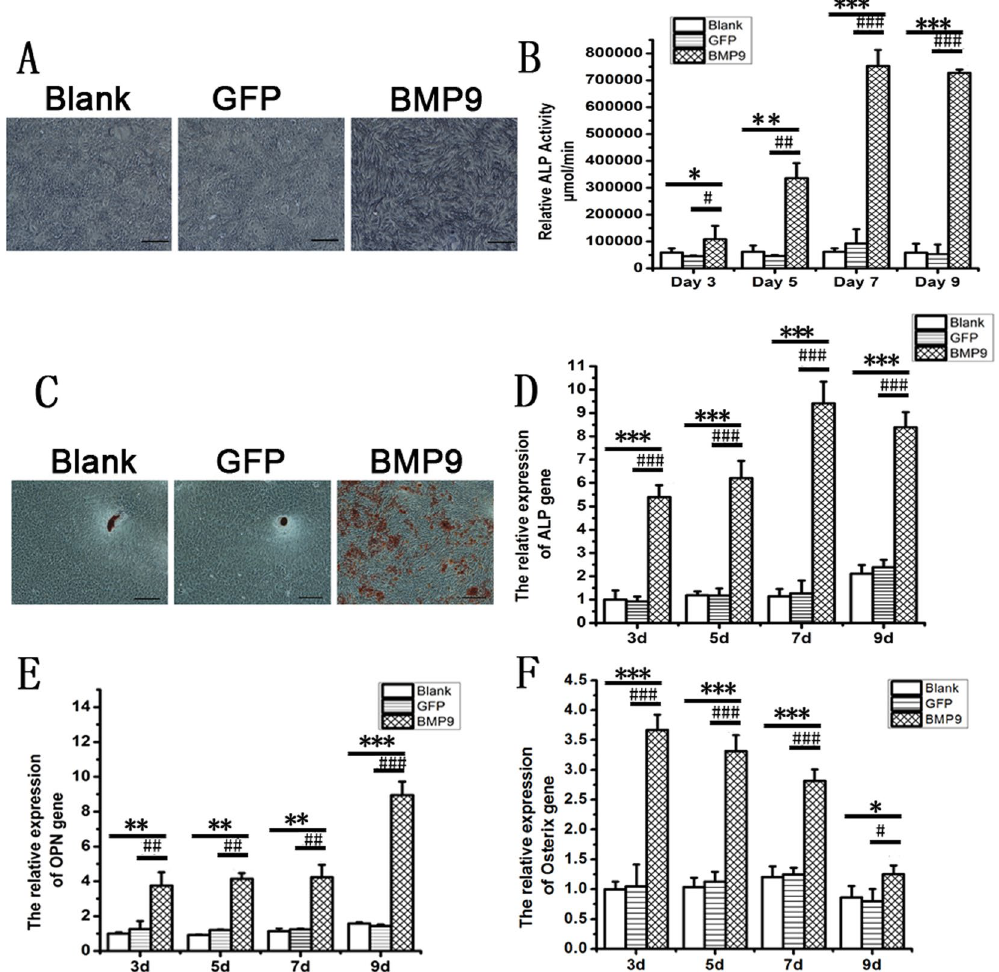
Figure 2. BMP9-induced osteogenic differentiation of rDFCs. ( A ) ALP staining intensity was enhanced in BMP9 group when compared with the blank group and GFP group. Bars: 50 μ m. ( B ) ALP activity was also significantly increased on days 3, 5, 7, 9 in BMP9 group when compared with the blank group and GFP group. ( C ) Calcium deposition was stained by Alizarin red staining. More calcified nodules were found in BMP9 group when compared with the blank group and GFP group. Bars: 50 μ m. ( D , E and F ) the relative expression of ALP, OPN, and Osterix were detected by Real Time- q PCR. * P < 0.05, ** P < 0.01, *** P < 0.001, compared with blank group, # P < 0.05, ## P < 0.01, ### P < 0.001, compared with GFP